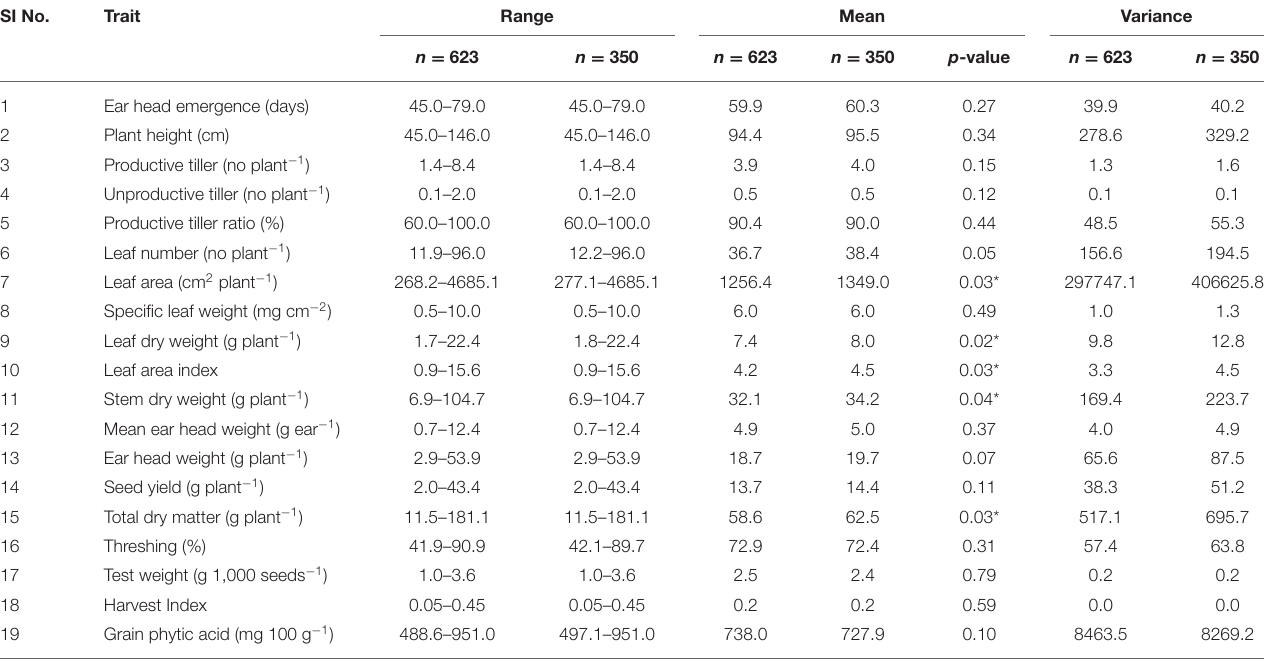
TABLE 1 | Comparison of mean, range, and variance for 19 quantitative traits in finger millet core collection ( n = 623) and diversity panel ( n = 350). SI No.